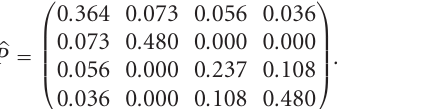
pentagons in the figure) and 18 nodes (circles and triangles in the figure),